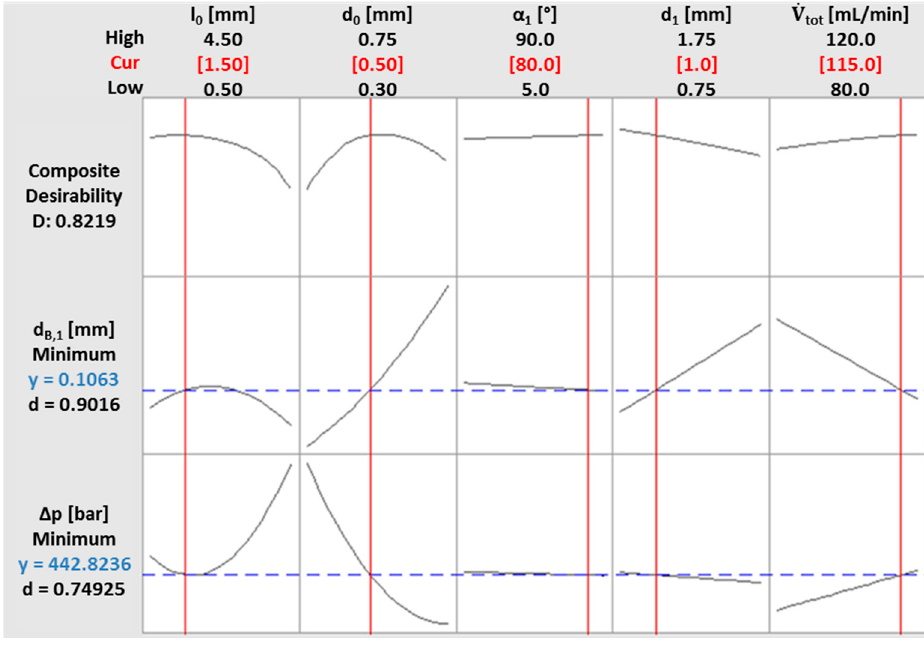
Figure 20. Factor optimization tool in Minitab® 17 for daughter bubble size and pressure drop.